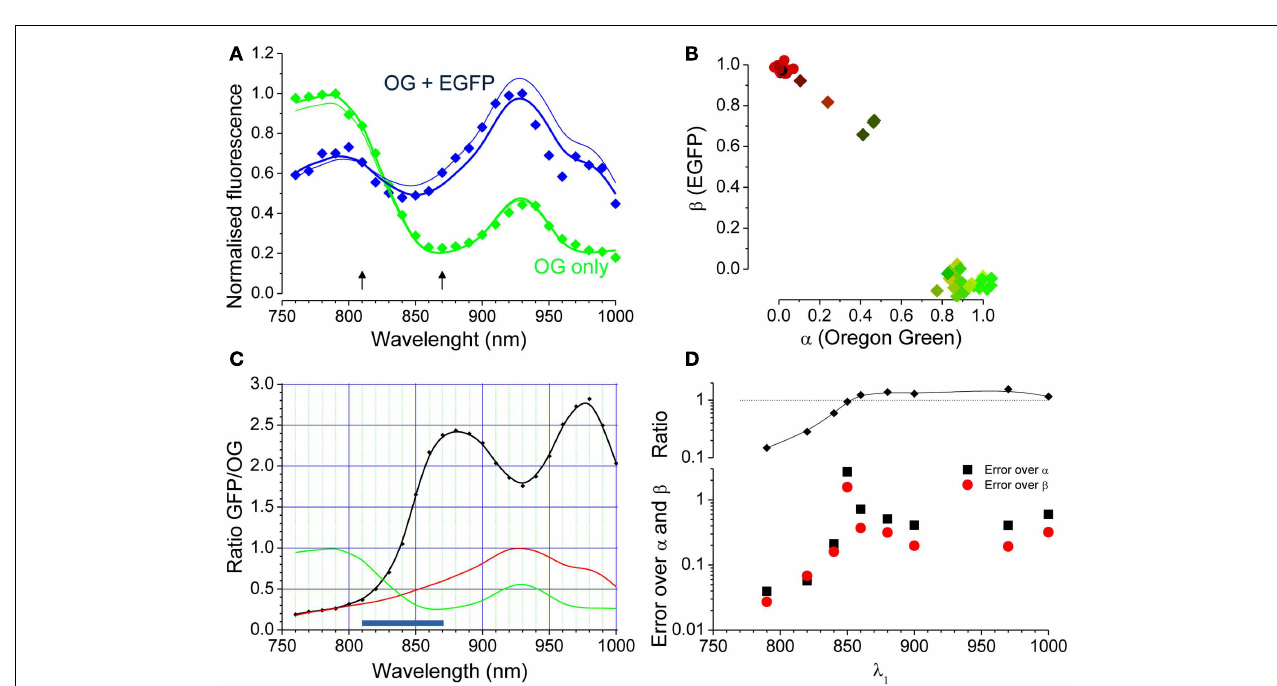
respectively). (D) α and β have been computed using images obtained at two wavelengths and the plot represents the difference between this estimate and the estimate obtained by fitting of the full spectra. One wavelength was fixed at 930nm and the second varied as plotted in the graph.The average differences between the estimates (black and red symbols for α and β respectively) were computed by applying this procedure on the data obtained from 31 cells fluorescent for OG and EGFP in various degrees.The upper panel shows the ratio [EGFP( λ 1 )/OG( λ 1 )]/[EGFP( λ 2 )/OG( λ 2 ); with λ 2 = 930nm]. As expected, the two wavelength estimates get worse when the ratio is close to